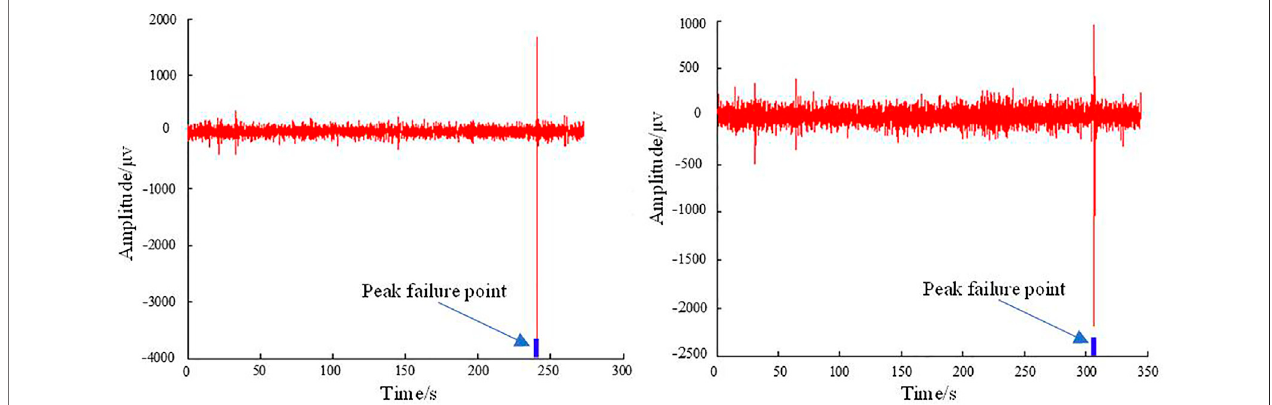
FIGURE 2 | Test results of infrasound signal during coal sample loading